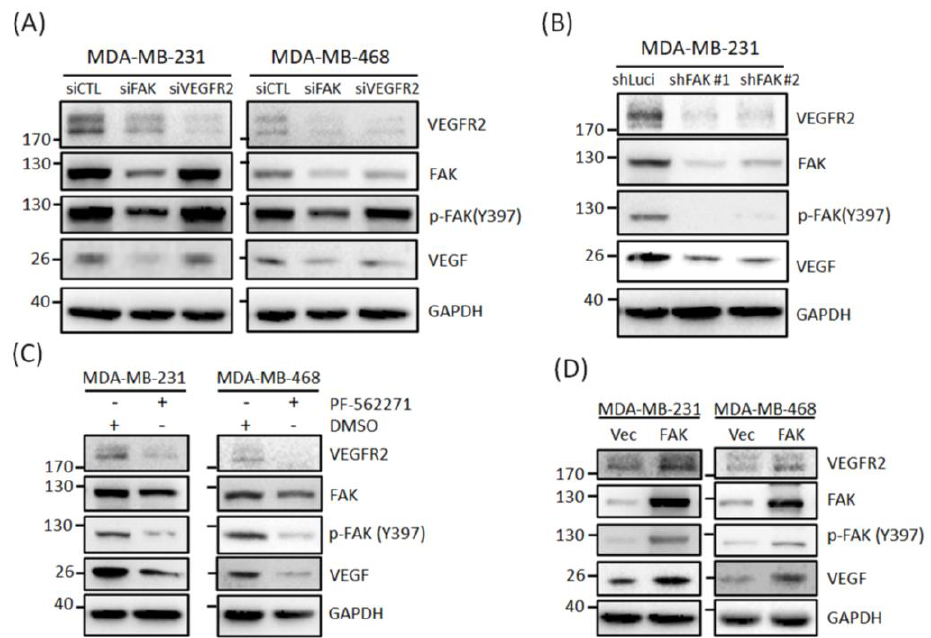
Figure 4. VEGFR2 protein expression is modulated through gene regulation by FAK in TNBC cells. ( A ) Knockdown of FAK decreased protein expressions of VEGFR2, p-FAK, and VEGF but knockdown of VEGFR2 did not affect these protein expressions in MDA-MB-231 and MDA-468 cells. ( B ) Protein expressions of VEGFR2, p-FAK, and VEGF were reduced in two stable clones of knockdown FAK MDA-Mb-231 cells. ( C ) VEGFR2 protein expressions in MDA-MB-231 and MDA-MB-468 cells were significant suppressed through PF-562271 treatment. ( D ) Overexpression of FAK could also increase VEGFR2, p-FAK, and VEGF protein expression in MDA-MB-231 and MDA-MB-468 cells.